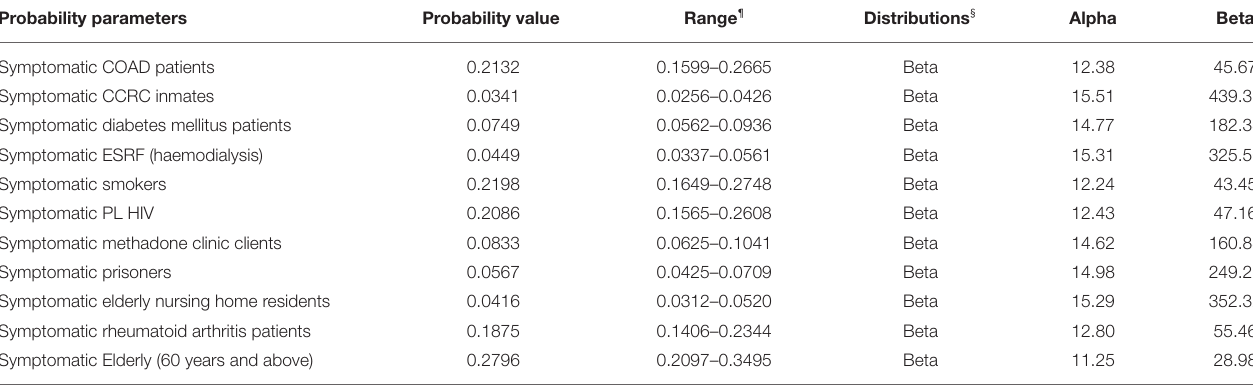
TABLE 2 | Clinical input data for